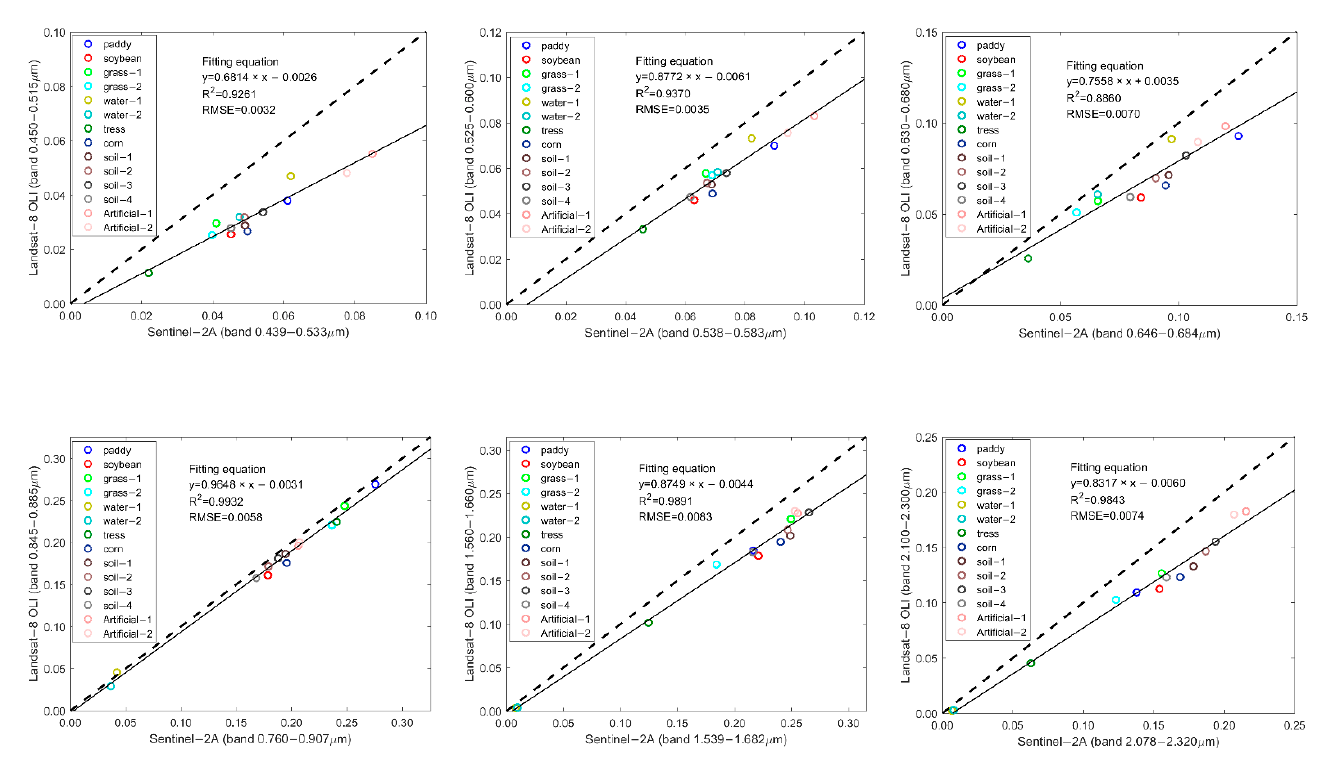
Figure 5. Statistical results by pseudo − invariant polygon features with single − band data.